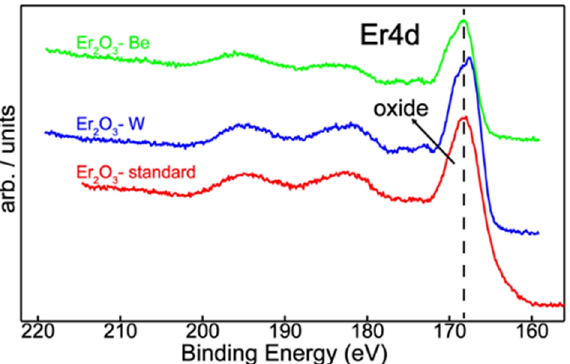
Figure 6. Er4d XPS superimposed spectra for the three stages of the Er system; Er4d spectra indicated an oxidized erbium surface as Er 2 O 3 (168.6 eV).